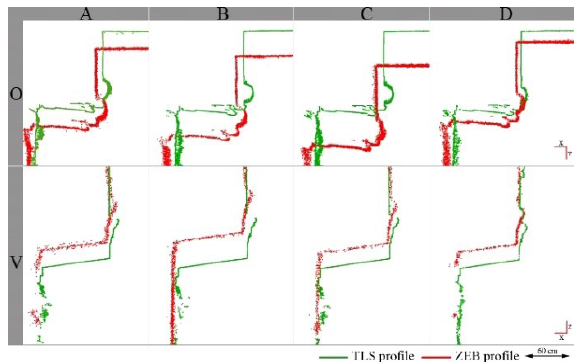
Figure 10. Configuration II, single local alignment . Misalignment errors detected in opposite corners in case of the single local point alignment, related to the O and V areas, pinpointed in Figure 9, according to the processing steps A, B, C, D: O in the horizontal slice, V in the vertical